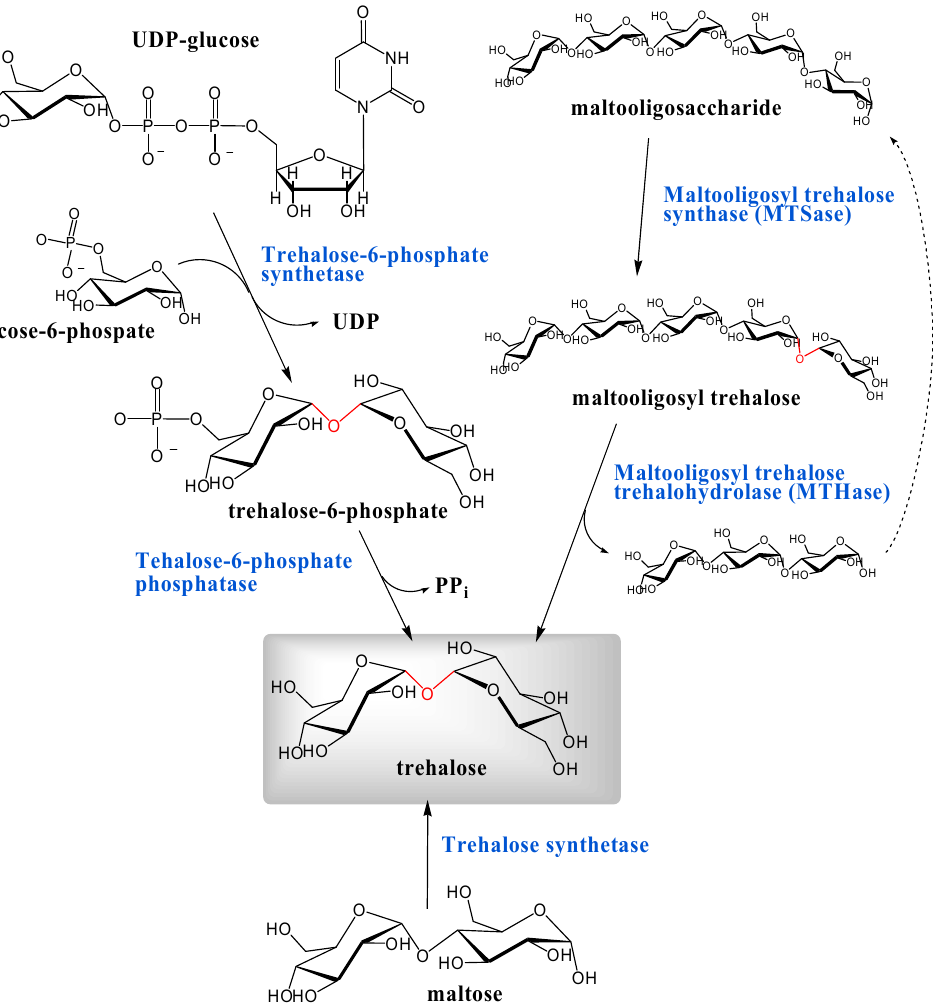
Figure 4. Three pathways for biosynthesis of trehalose. α,α -1,1-Glycosidic linkages are indicated in